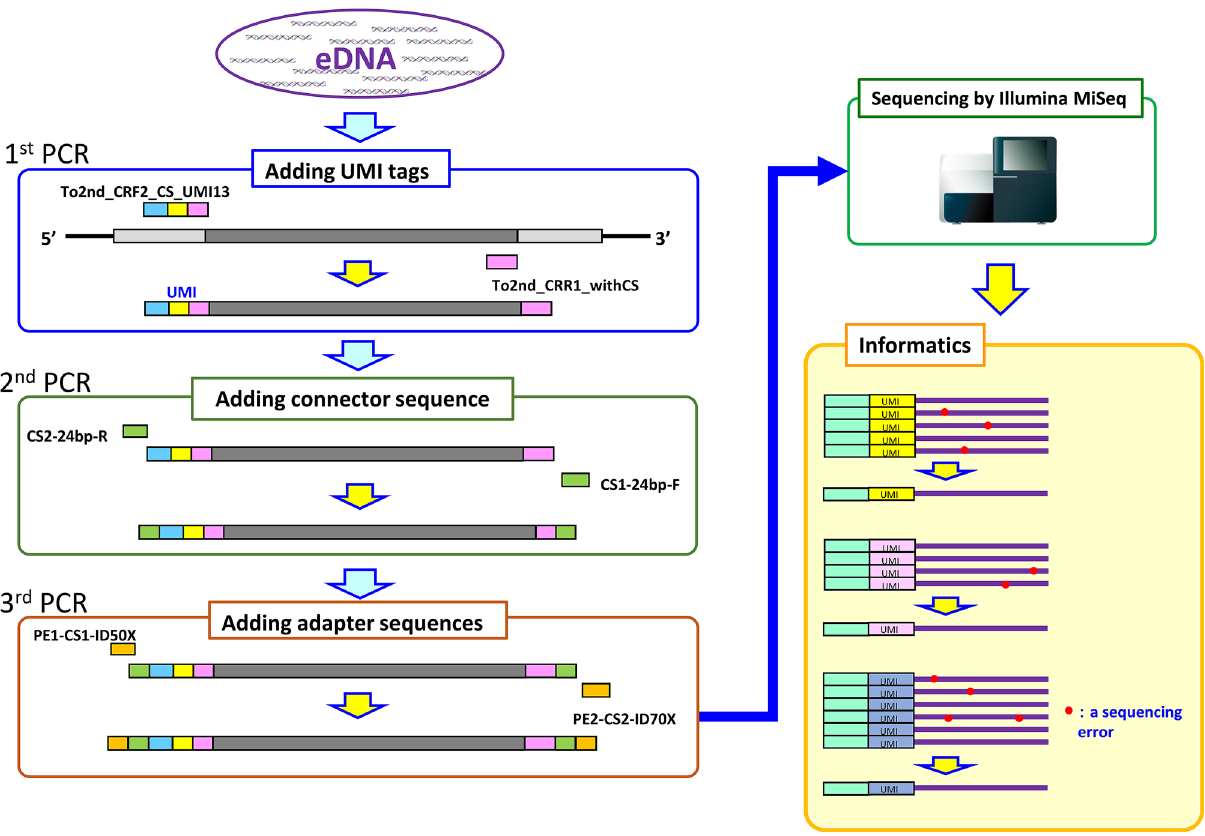
Figure 2. Principle of eliminating PCR errors and sequencing errors using unique molecular identifier (UMI) tags. Assign one random UMI tag per molecule in the first PCR; amplify by including the UMI tag in the second PCR; sequence with MiSeq; collect reads with the same UMI tag; perform error correction by removing different bases. The image of a sequencer is from TogoTV (©2016 DBCLS TogoTV/CC-BY-4.0).